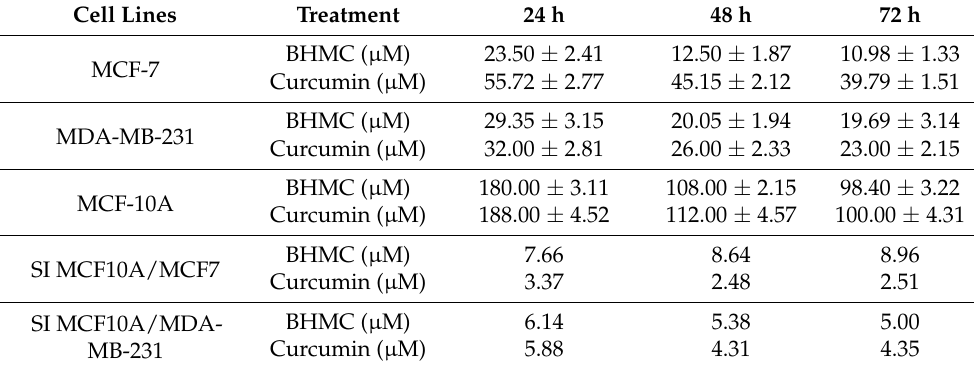
Table 1. IC 50 values and selectivity index (SI) of MCF-7, MDA-MB-231, and MCF-10A treated with BHMC or curcumin. IC 50 was reported as mean + standard deviation (SD) and the results were generated from three biological replicates, and each biological replicate contained three technical replicates. SI: Selectivity